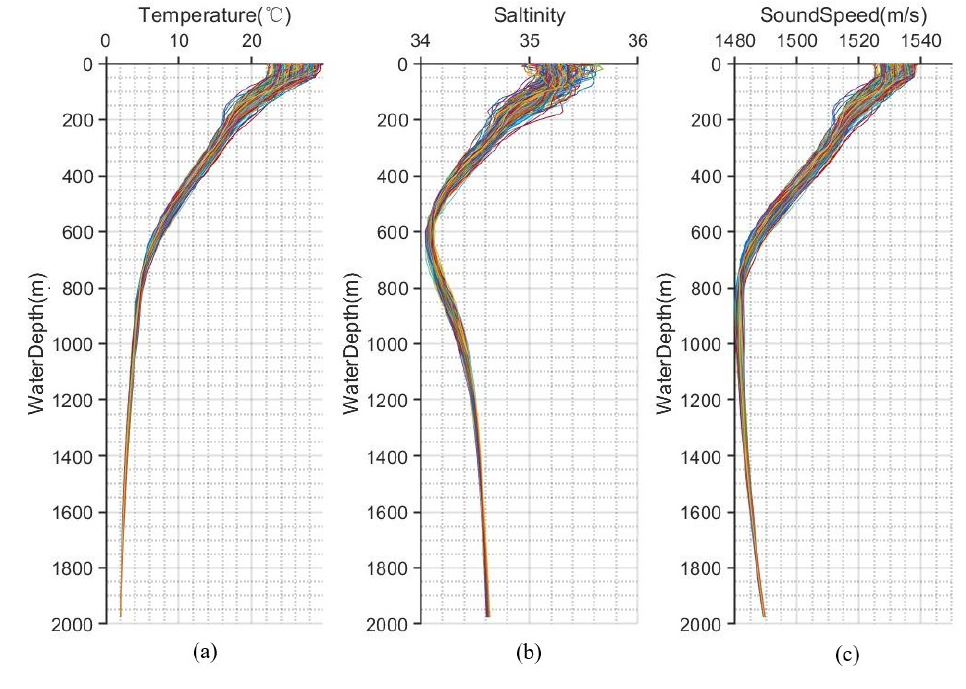
Figure 2. The profile data from BOA_Argo in (24.5° N, 169.5° W): ( a ) Temperature profiles; ( b ) salinity profiles; ( c ) sound speed